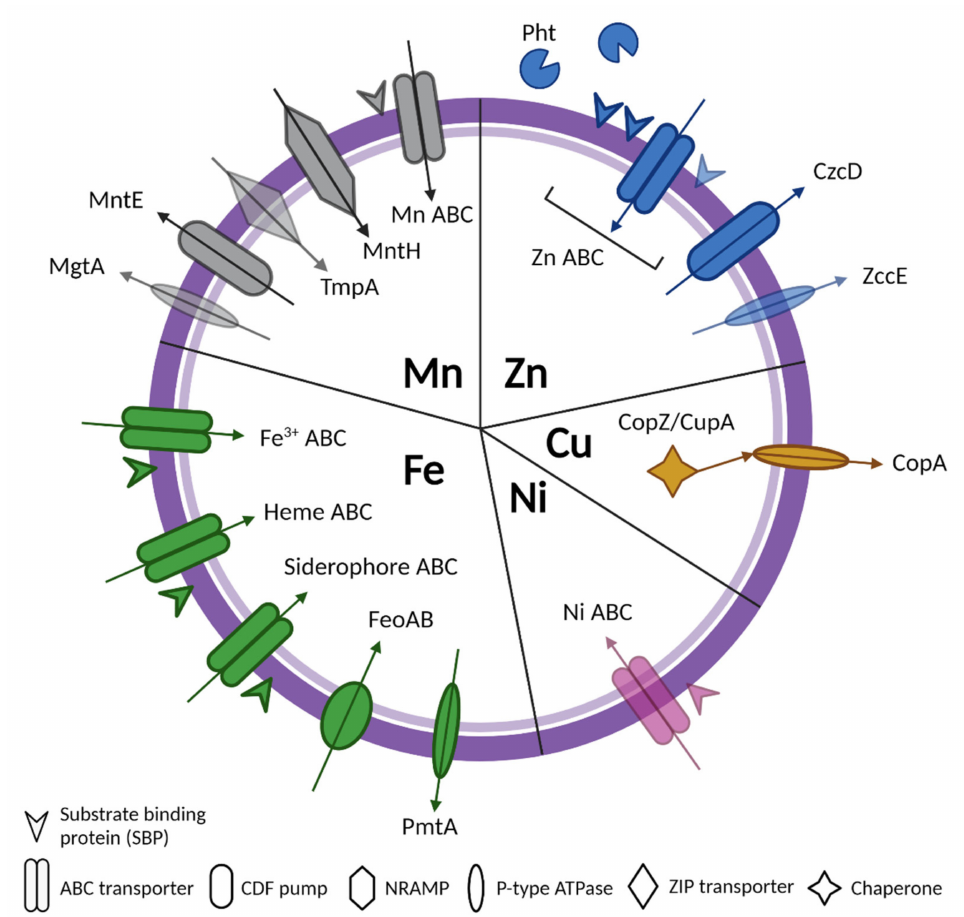
Figure 1. A summary diagram of all known types of transporters for Zn, Mn, Fe, Cu, and Ni in Streptococci with arrows indicating metal import or export. Transparent shapes represent trans- port systems that are only characterized in one species, including MgtA ( S. pneumoniae ); TmpA ( S. sanguinis ); a third zinc SBP ( S. agalactiae ); ZccE ( S. mutants ); and Ni ABC ( S. salivarius ). Created using